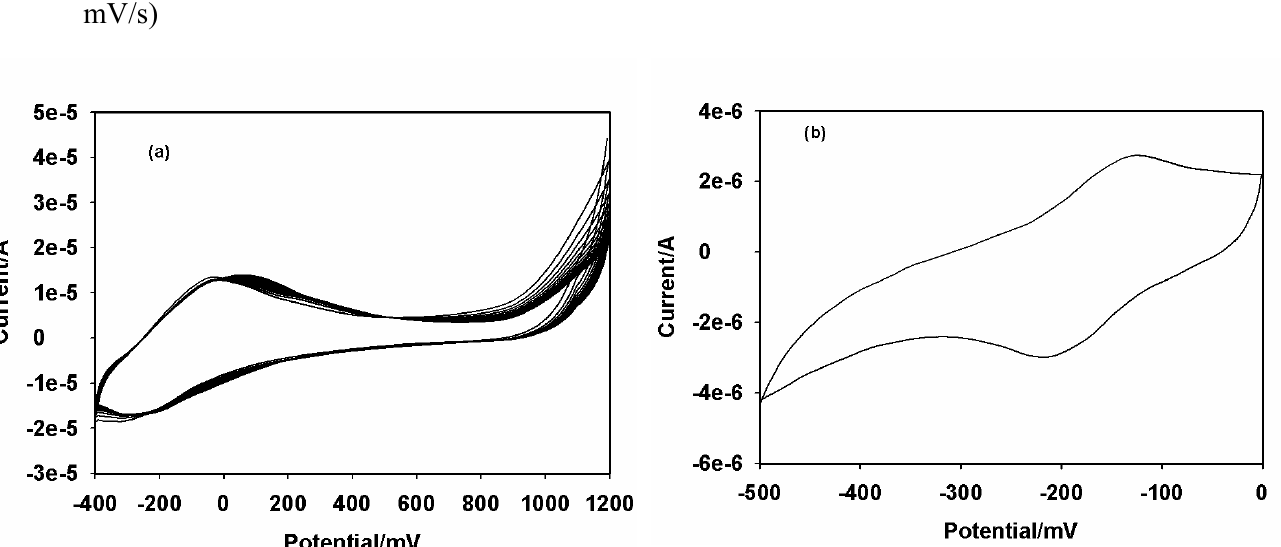
Figure 3. Cyclic voltammograms (a) for the synthesis of PTH from 0.1 mM thionine in acetate buffer (pH 6.5); and (b) of GCE|PTH in acetate buffer (pH 6.5). (Scan rate: